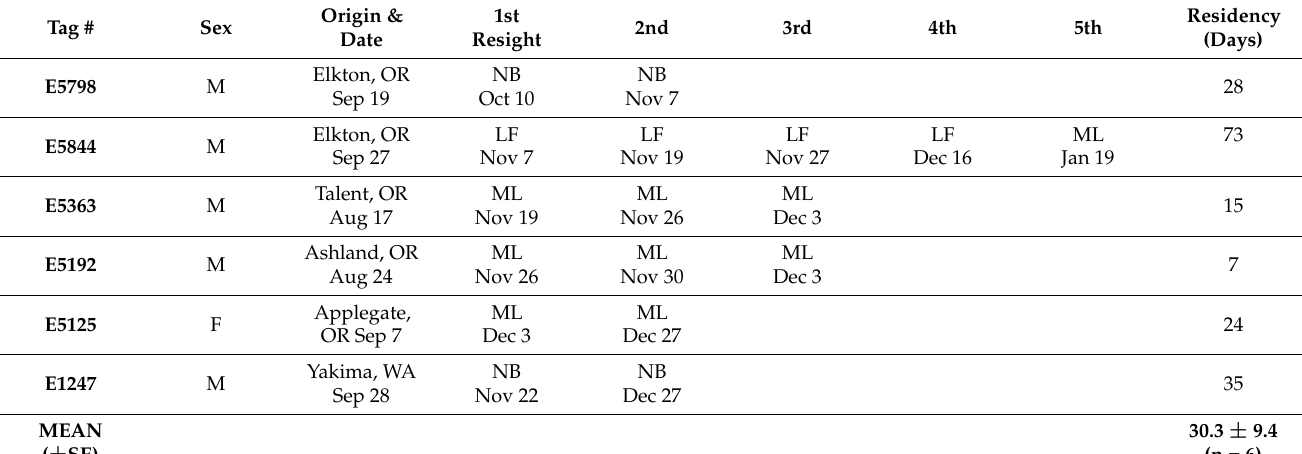
Table 6. Re-sighting data for tagged captive-reared monarchs in California in 2018. All data from overwintering sites in Santa Cruz: NB = Natural Bridges State Beach, LF = Lighthouse Field State Beach, ML = Moran Lake. Residency = period spent at overwintering site